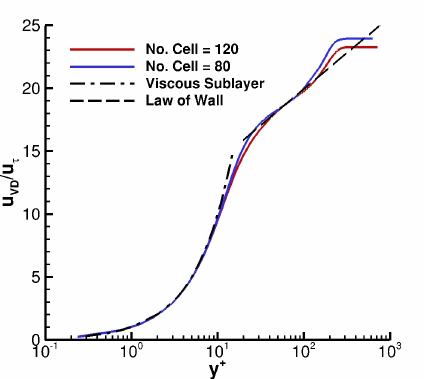
Figure 16. Energy Spectra for: ( a ) T w / T aw = 0.54. ( b ) T w / T aw = 0.79. ( c ) T w / T aw = 1.00. ( d ) Com- bined.